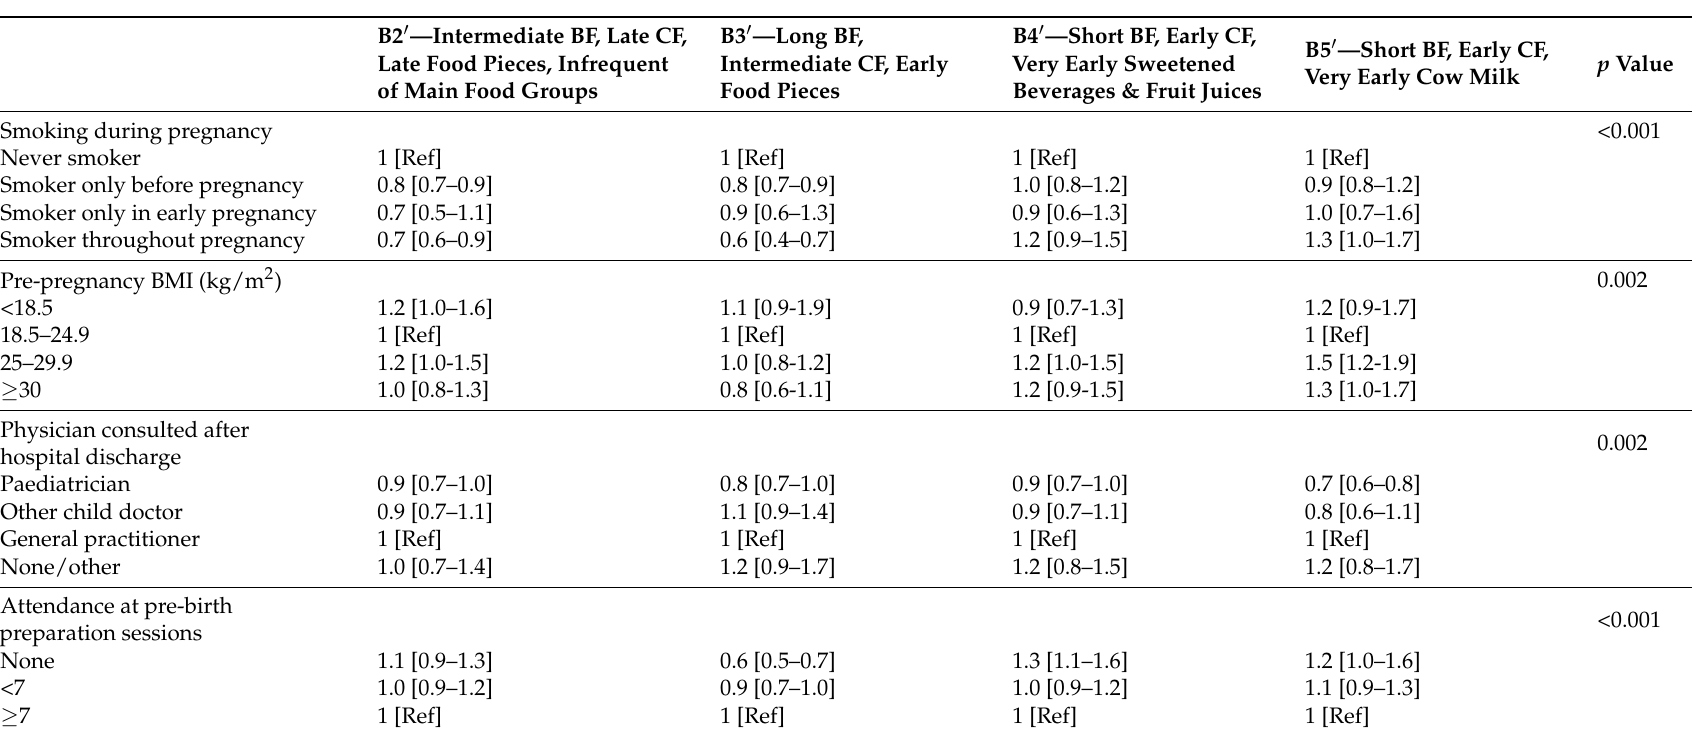
Table 7. Multivariable multinomial logistic regression analysis explaining clusters (identified by HAC) by family characteristics (not shown) and health-related variables ( n =